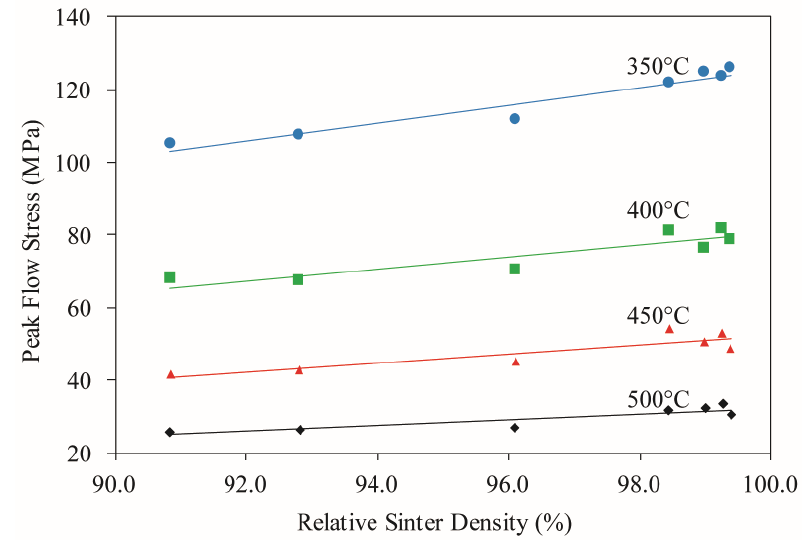
Figure 9. Effect of preform sintered density on the peak flow stress; samples deformed at a strain rate of 0.05 s −1 and temperatures 350 °C to 500 °C .